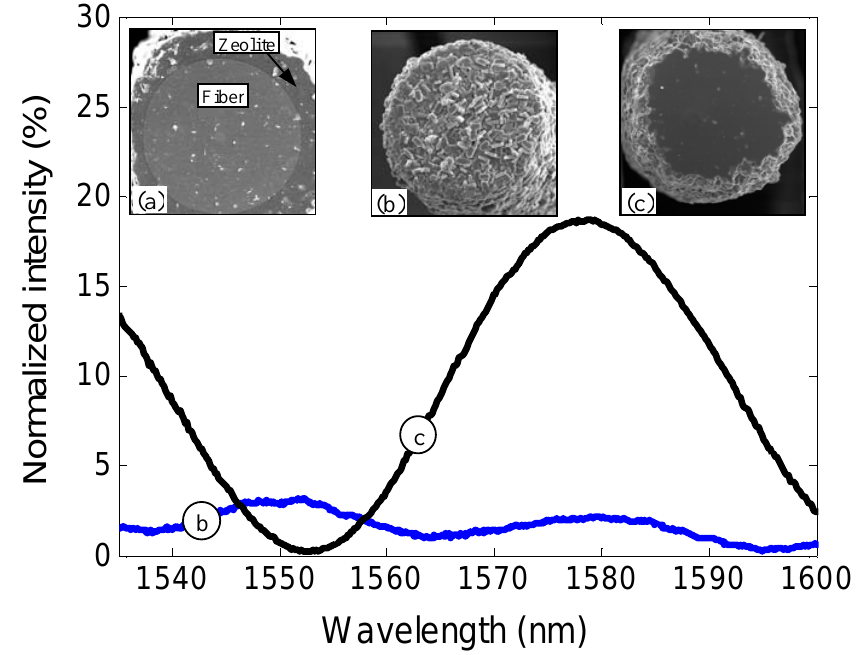
Figure 2. SEM images of the zeolite thin films grown on optical fiber and the interference signals before and after polishing. (a): cross section, (b): unpolished outer surface and interference signal, and (c): polished outer surface and improved interference